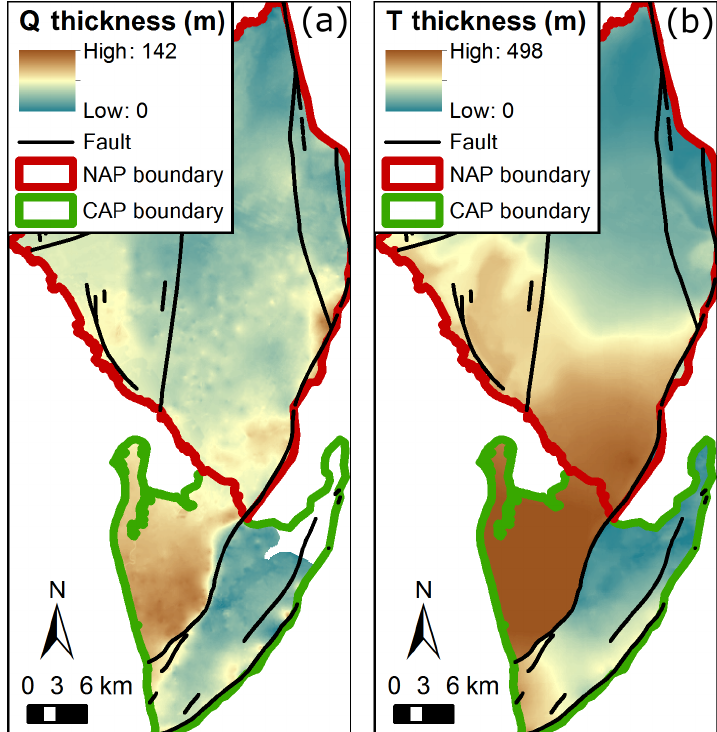
Figure 6. Total thickness of the Quaternary (Q) sediments (a) and Tertiary (T) sediments (b) in the AP basin. The colour schemes are different in (a) and (b)